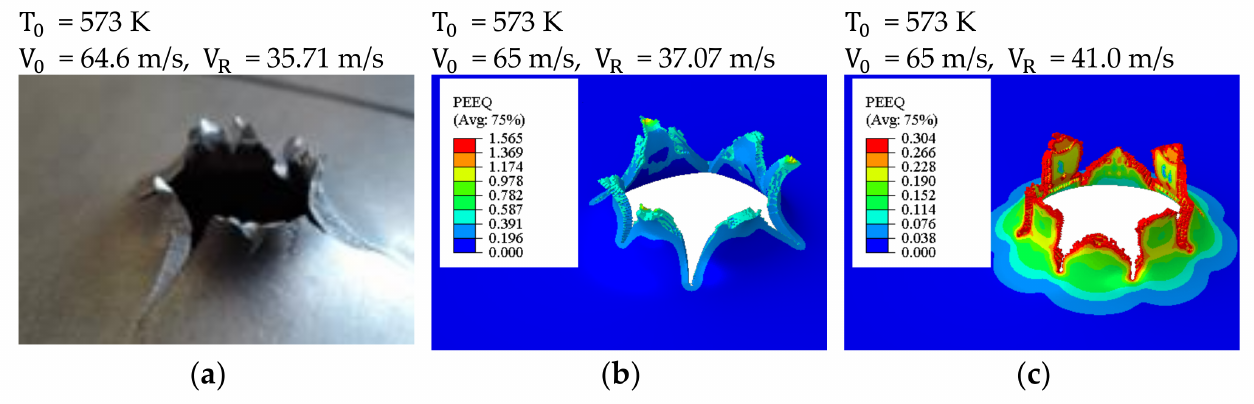
Figure 7. Petalling observed during the numerical simulation: V 0 = 65 m/s, T 0 = 573 K; the sequence of pictures: ( a ) experiment, ( b ) simulation using the Johnson–Cook failure criterion (our own work), ( c ) simulation using a constant initiation damage parameter.